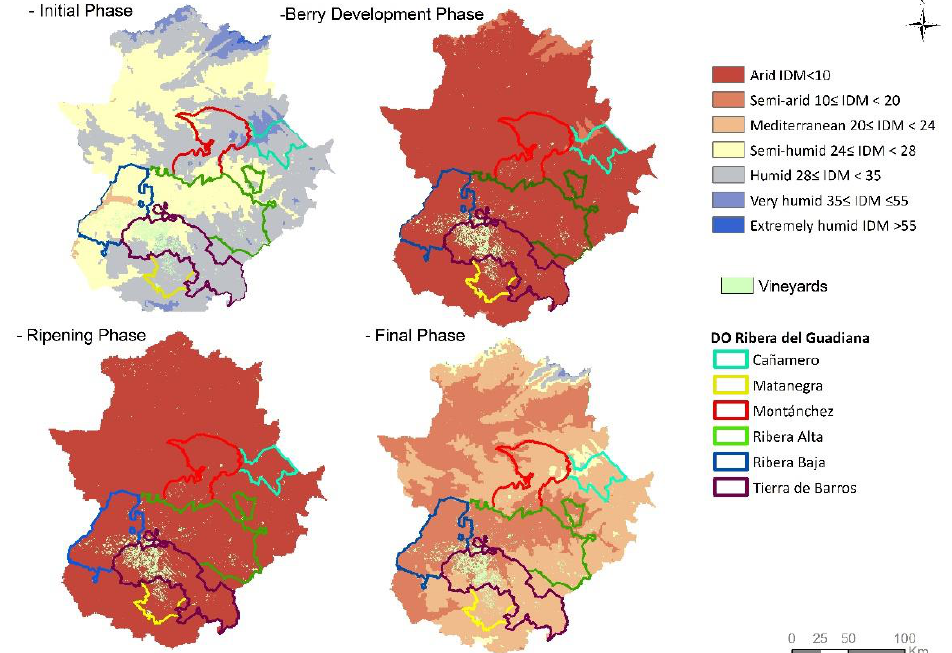
Figure 5. Spatial distribution of the De Martonne aridity index in Extremadura (1989–2020) for the initial, growth, middle, and final phases. Vineyards and subzones of the Ribera del Guadiana Protected Denomination of Origin are also shown. Table 4. Spatial classification (%) of the Ribera del Guadiana Protected Denomination of Origin, according to the IDM for the vine phases (1989 – 2020).